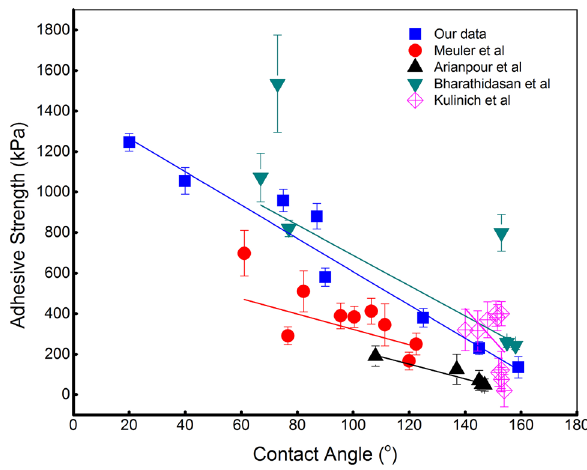
Figure 1. The original version of Figure